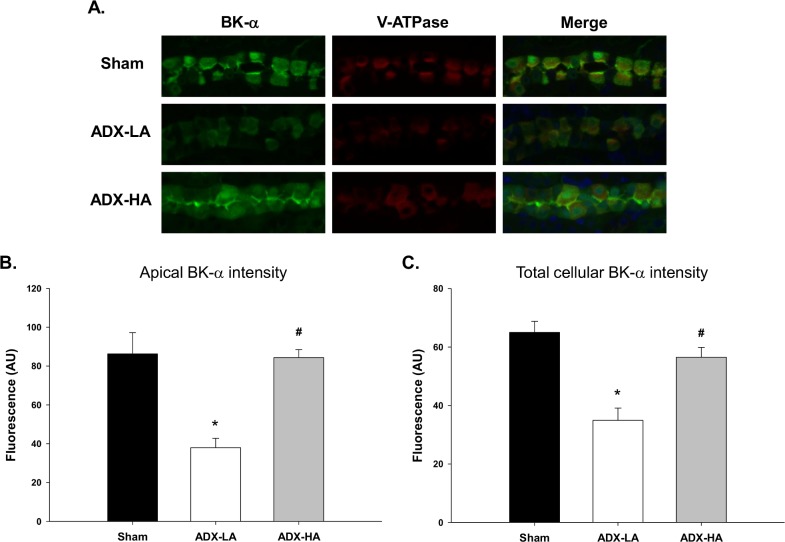
The effect of aldo on BK-α expression in the distal nephron of LNaHK mice.Representative images (A) and bar plots summarizing intensity of fluorescent immunohistochemical staining of apical (B) and total (C) BK-α in cortical kidney sections of sham, ADX-LA, and ADX-HA mice. BK-α (green) was co-stained with V-ATPase (red), a marker of intercalated cells in the connecting tubule and collecting duct. Merged images also contain Hoechst nuclear stain (blue). * P < 0.001 vs. sham; # P < 0.001 vs. ADX-LA; n = 9.